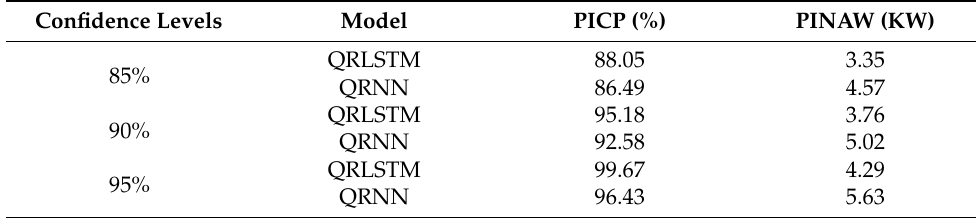
Table 1. Comparison of evaluation indicators on similar-day 1.